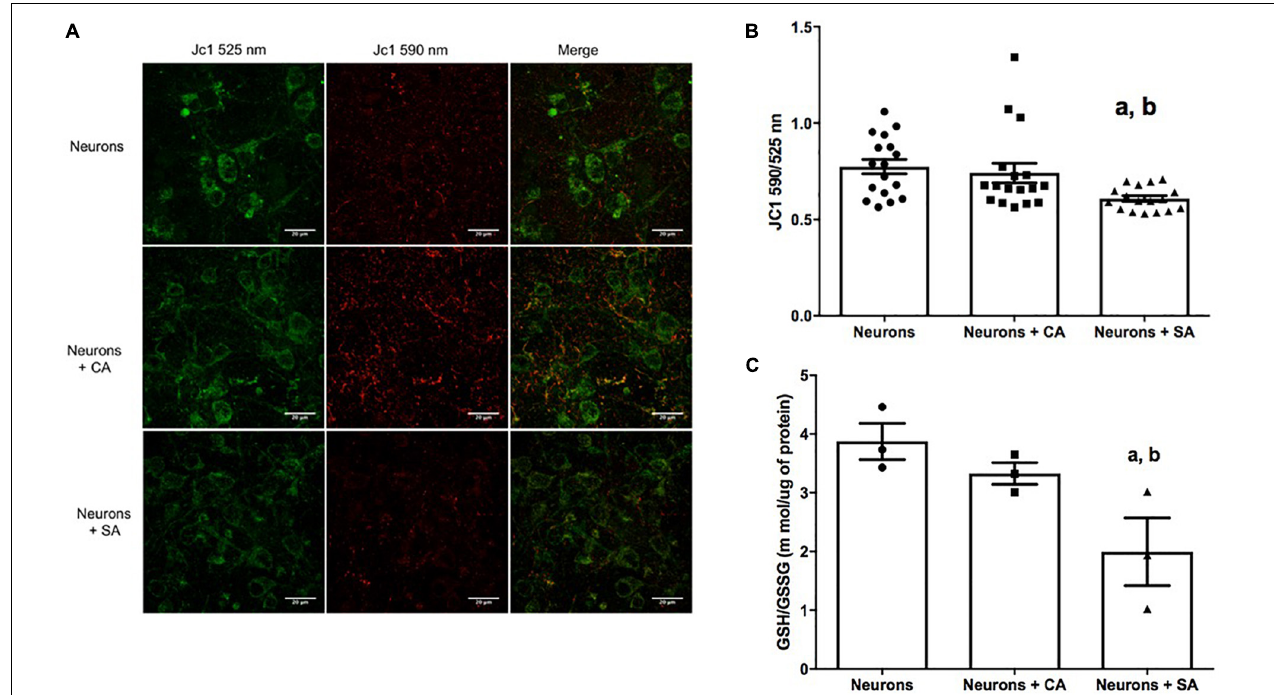
FIGURE 3 | Senescent astrocytes decrease neuronal mitochondrial membrane potential ( (cid:49)(cid:57) m) and the redox state. (A) Neurons representative micrographs. (cid:49)(cid:57) m was assessed by using the cationic colorant JC1 as described in materials and methods; the J-aggregates were determined at 590 nm (green) and the single molecules were determined at 525 nm (red). (B) 590/525 nm ratio quantification. (C) Reduced glutathione/oxidized glutathione (GSH/GSSG) ratio. Each bar represents the mean ± SE of three independent experiments for panels (A,B) and two experiments for panel (C) . Statistical significance with respect to a. p ≤ 0.05 vs. neurons and b. p ≤ 0.05 vs. neurons +CA, tested by the ANOVA and the Tukey–Kramer test.